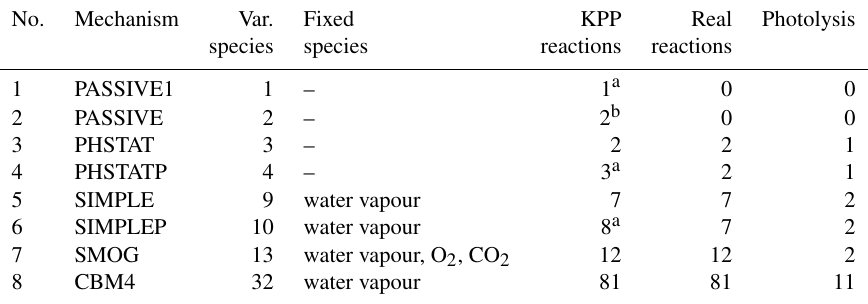
Table 1. Description of built-in chemical mechanisms. No. Mechanism Var. Fixed KPP Real Photolysis species species reactions reactions 1 PASSIVE1 1 – 1 a 0 0 2 PASSIVE 2 – 2 b 0 3 PHSTAT 5 SIMPLE 9 water vapour 6 SIMPLEP 10 water